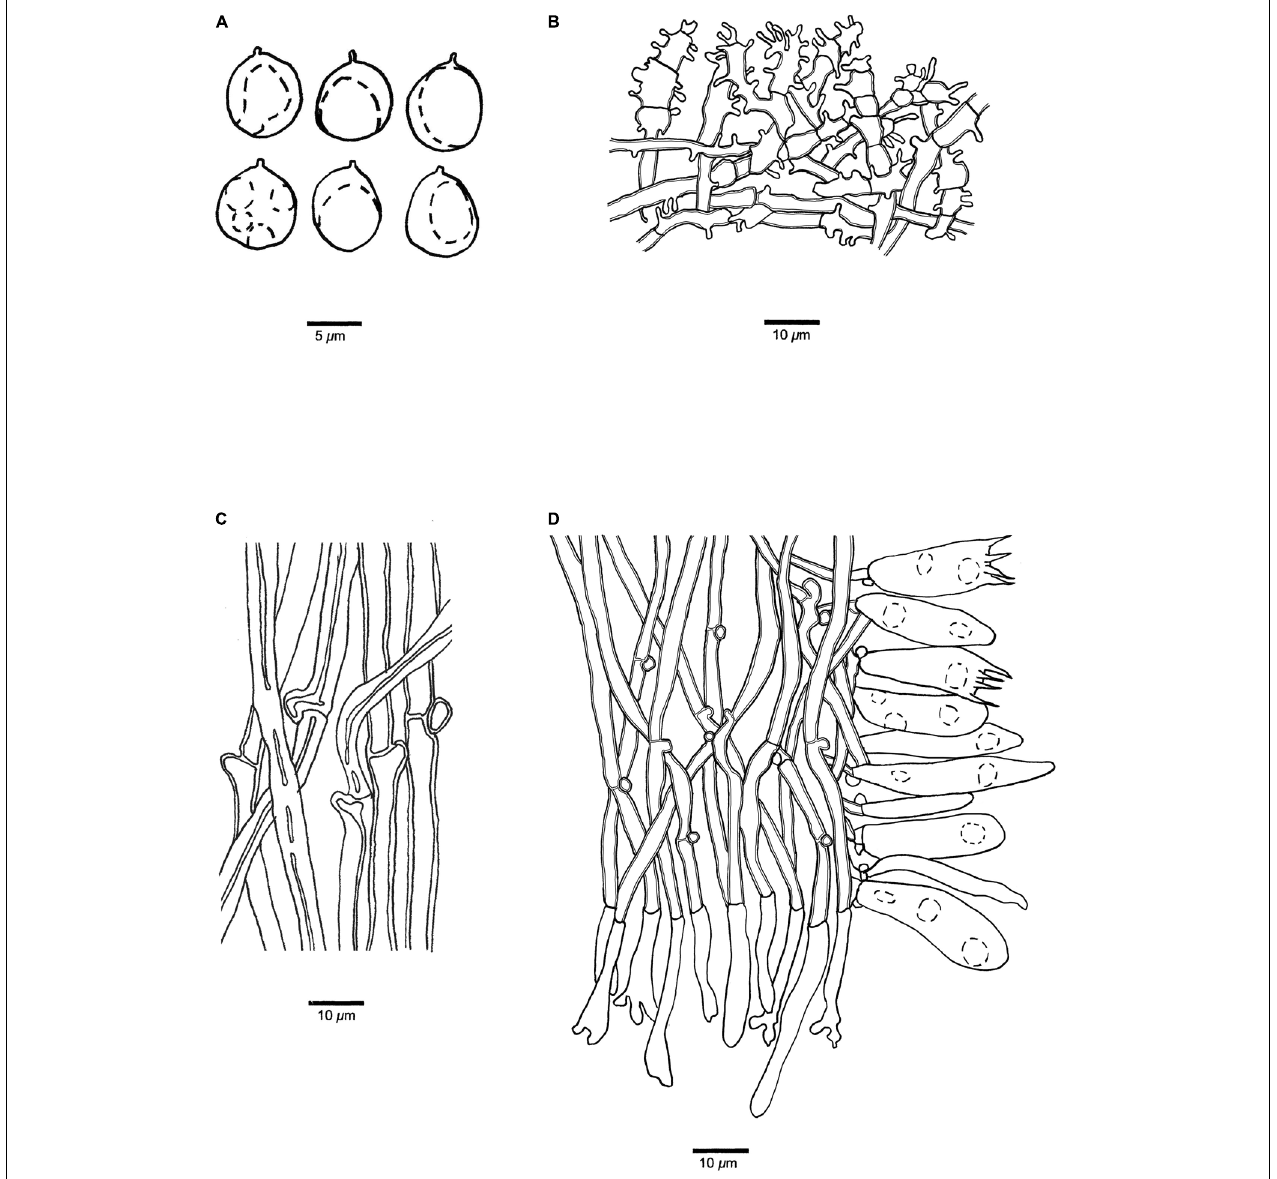
FIGURE 9 | Microscopic structures of Panellus palmicola (holotype). (A) Basidiospores. (B) Dichophysial hyphae from pileipellis. (C) Hyphae from stipe. (D) A section of tube trama, including pleurocystidia, cheilocystidia, basidia, and basidioles. The dotted circles represent some guttules in basidiospores, basidia or